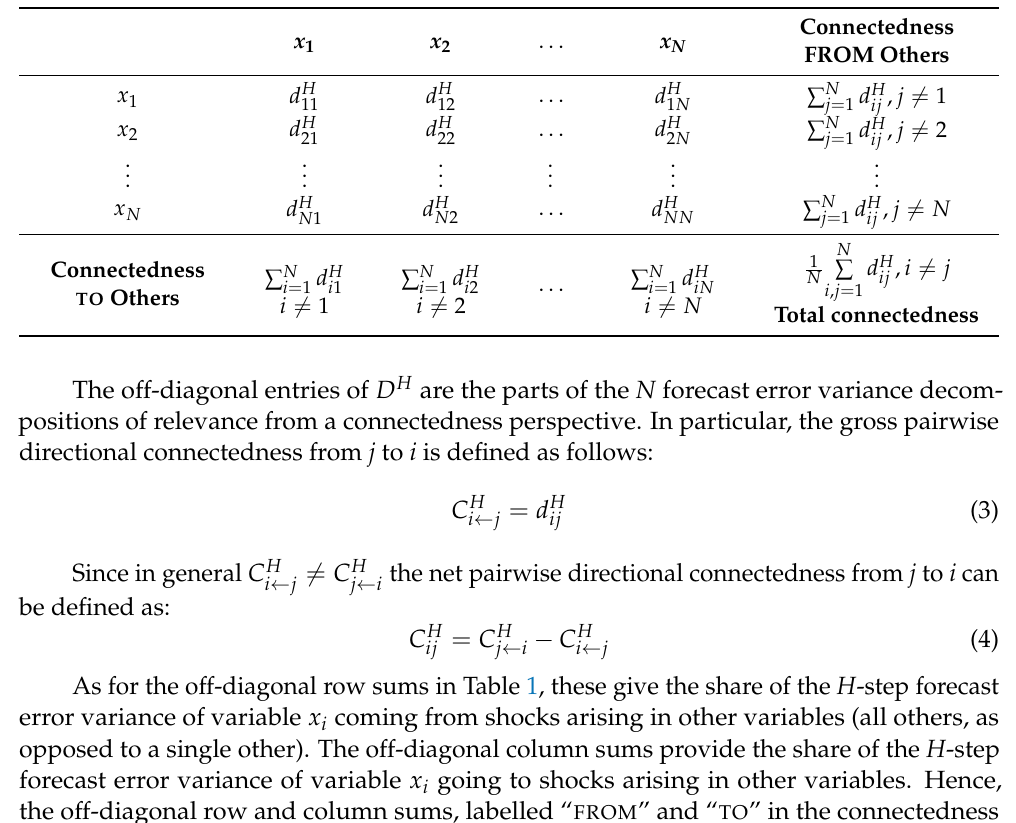
d H 12 d H 22 . . . d H N 2